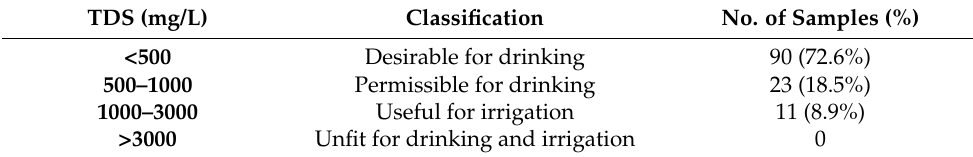
Figure 8. Piper diagram [39] indicating water types in the Soutpansberg region. Table 4. Groundwater classification based on TDS